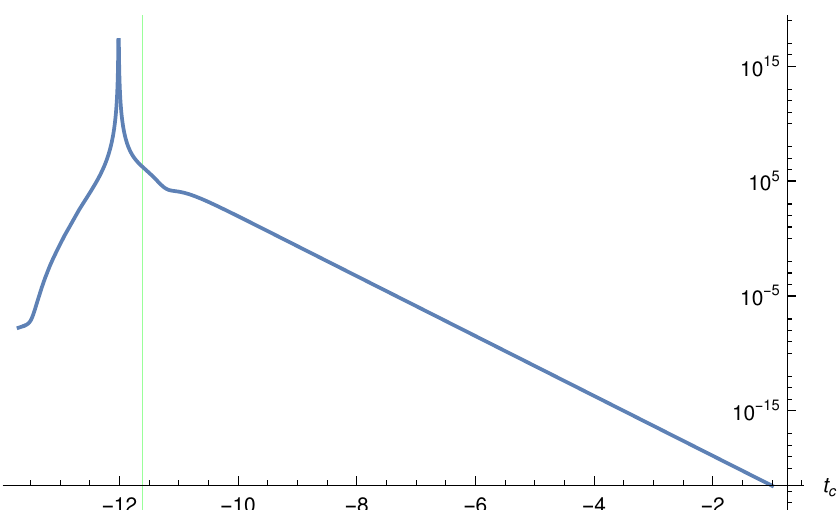
Figure 7. The Kretschmann scalar near the transition surface τ ts (cid:39) − 11.6201 denoted by the vertical line for the case α 1 = 0. Here m = 10 6 , ( ω cc , ω cb ) = ( − δ c /3 m ,0 ) , and ( ω bb , ω bc ) = ( − δ b /3 m , δ b /3 m ) , so that ( Ω b , Ω c ) = ( 0, − δ c /3 m < 0 ) , where δ i ’s are given by Equation (26).